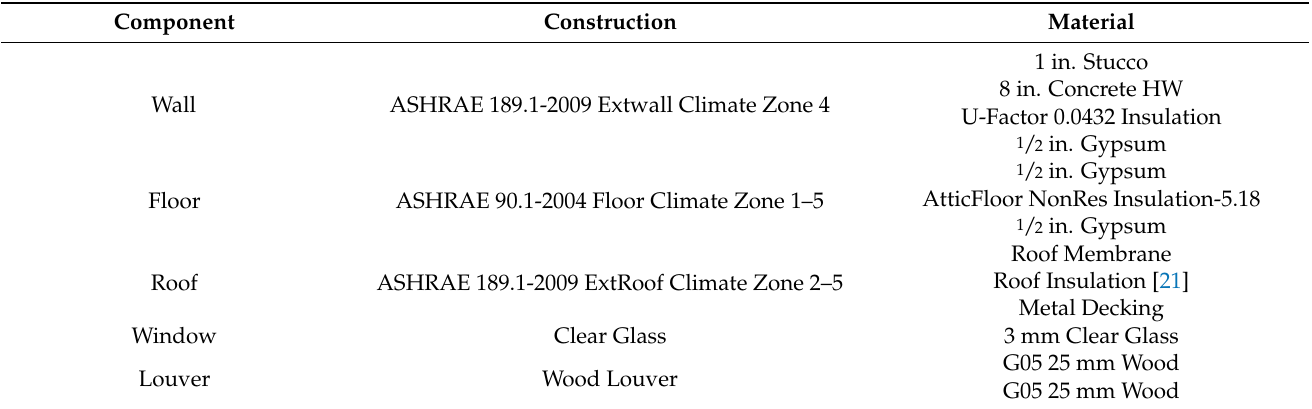
Table 2. Material of each component in the analysis